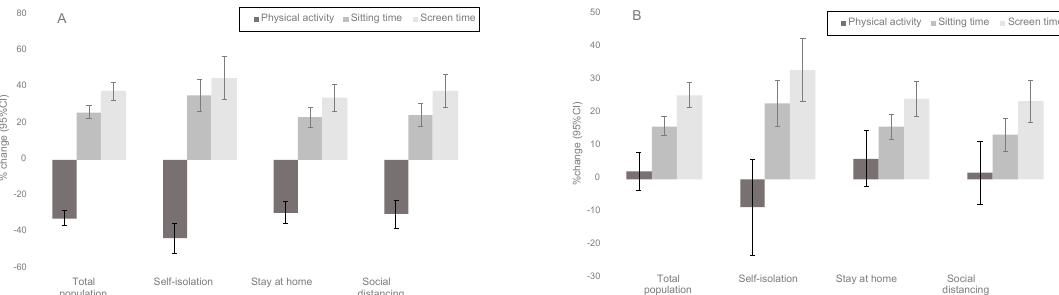
Figure 2. Mean percentage change (95% CI) in behaviors from before to after COVID-19 related public health restrictions in those who were previously ( A ) active and ( B ) inactive. Panel A shows those who met the minimum recommended physical activity levels prior to the restrictions ( n = 1361) by public health restriction category (i.e., self-isolation: n = 278; stay at home: n = 635; social distancing: n = 448), while Panel B shows those who did not meet the minimum recommended physical activity levels prior to the restrictions ( n = 1691) by public health restriction category (i.e., self-isolation: n = 272; stay at home: n = 827; social distancing: n = 592.